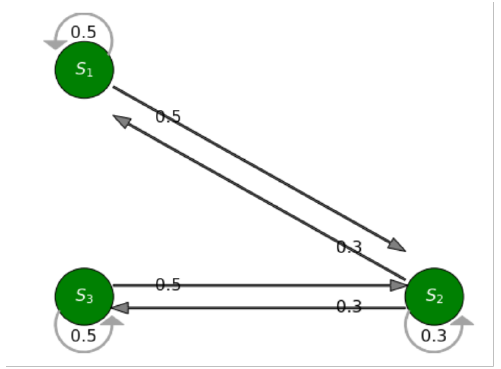
Figure 8. Three State Markov